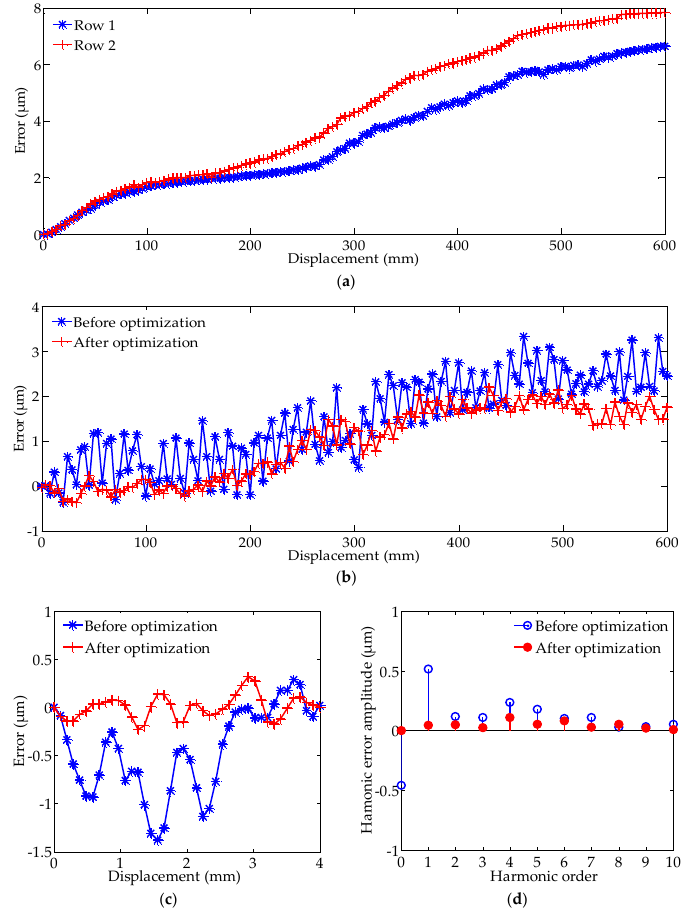
Figure 6. ( a ) Measurement errors of two rows of the initial prototype VATG sensor over the full measurement range. ( b ) Measurement errors of the VATG sensor obtained over the full measurement range before optimization and after optimization. ( c ) Measurement errors obtained over a single 4 mm period before optimization and after optimization. ( d ) Frequency spectra of measurement errors for a single 4 mm period before optimization and after optimization.